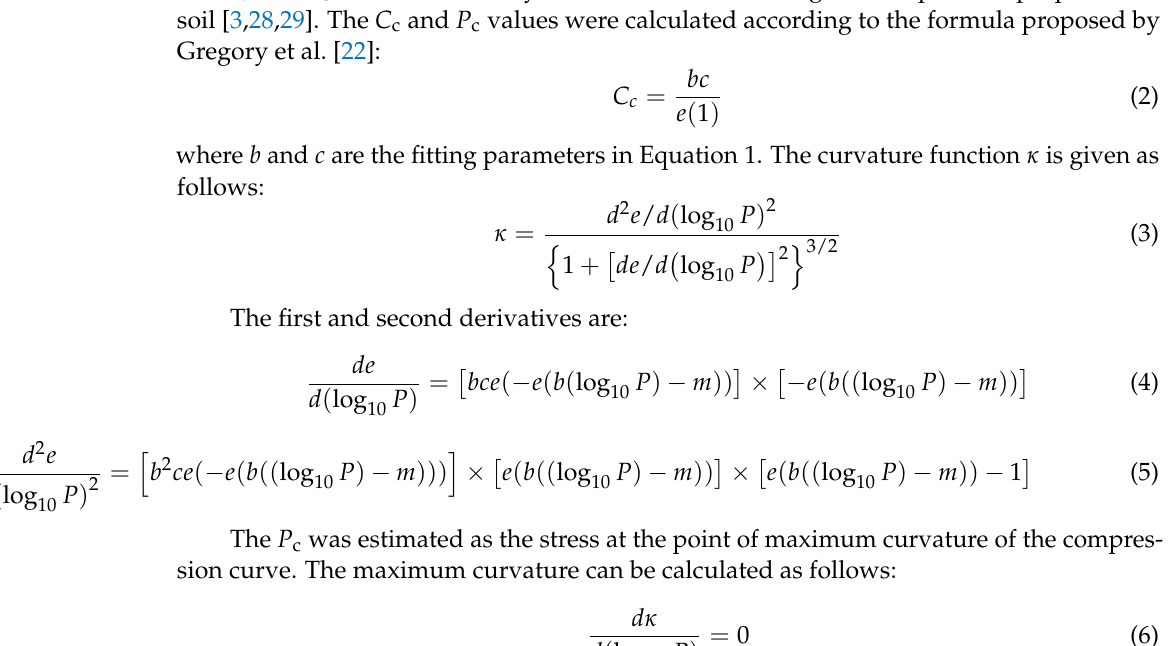
( d ) K = 95% Figure 5. The relationship between strain and H/D ratios under different compaction degrees. 3. Results and Discussion 3.1. The Relationship between Axial Strain and H/D Ratios Figure 5 shows the variation of axial strain with H/D ratios under different compac- tion degrees. We found that the axial strain decreases with the increase in H/D ratios and compaction degree. At the compaction degree of 78%, the axial strains with an H/D ratio of 0.32 and 1.62 at 50 kPa and 1600 kPa were 1.51%, 0.48% and 17.51%, and 7.11%, respec- tively. The results indicated that the larger the H/D ratio at the same pressure, the more difficult the sample was to compress. This is because as the H/D ratio increases, the friction area between the soil and the ring wall increases, and the soil–ring wall friction exerts an upward resistance on the sample, weakening the compaction effect of the external force on the sample. As the compaction degree increased to 95%, the axial strains at 50 kPa and 1600 kPa decreased to 0.89%, 0.21% and 4.41%, and 1.31% for samples with an H/D ratio of 0.32 and 1.62, respectively. The results indicated that the higher the compaction degree, the more difficult the sample is to compress. This is because the increase in compaction